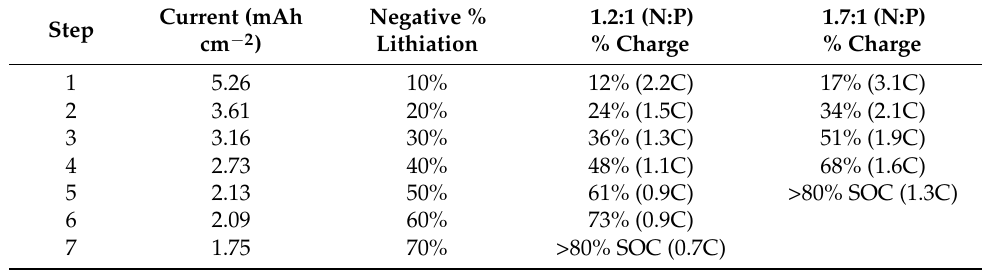
Table 3. Accelerated charging procedure applied to full NMC/MCMB cells, demonstrating the relationship between the percentage MCMB lithiation and full-cell charge percentage. The data shown are based off 300 mAh g − 1 and 150 mAh g − 1 for MCMB and NMC, respectively. C-rates shown represent the charging rate to reach each state of charge.